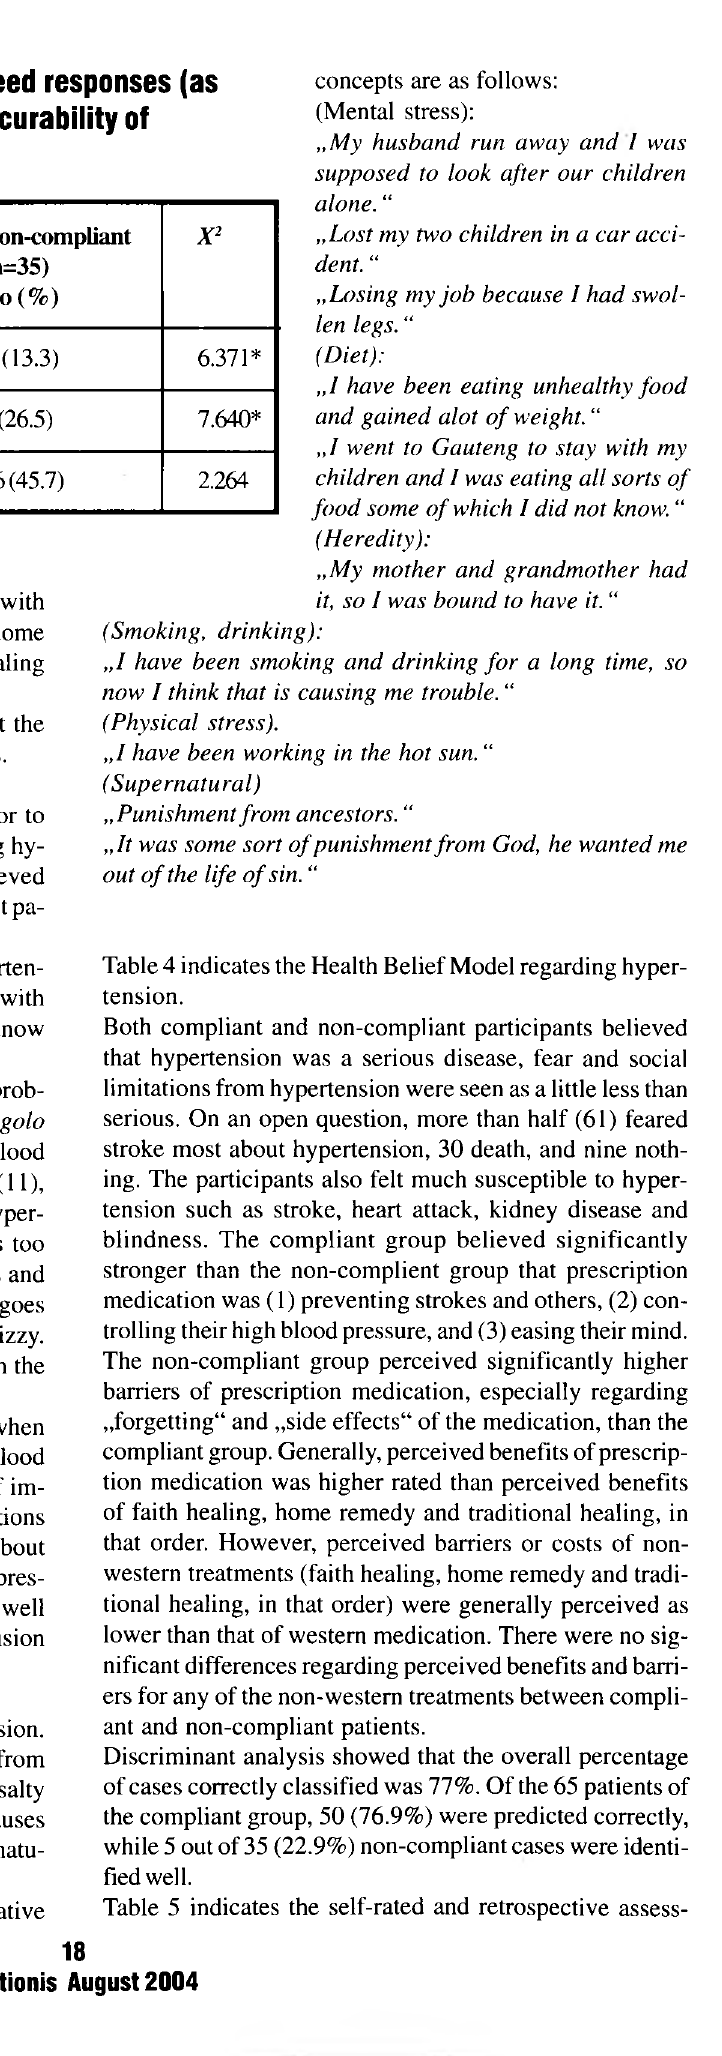
Table 5 indicates the self-rated and retrospective